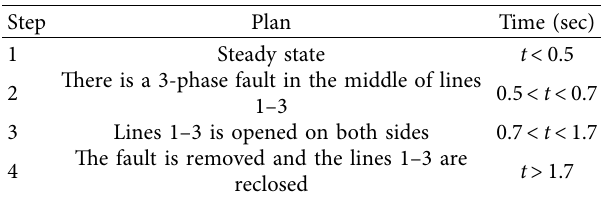
Table 2: Tree-phase fault planning.